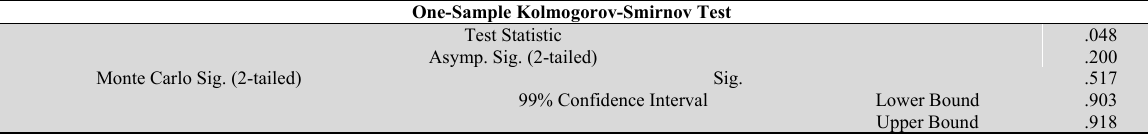
Normality test with One Sample Kolmogorov Smirnov Test